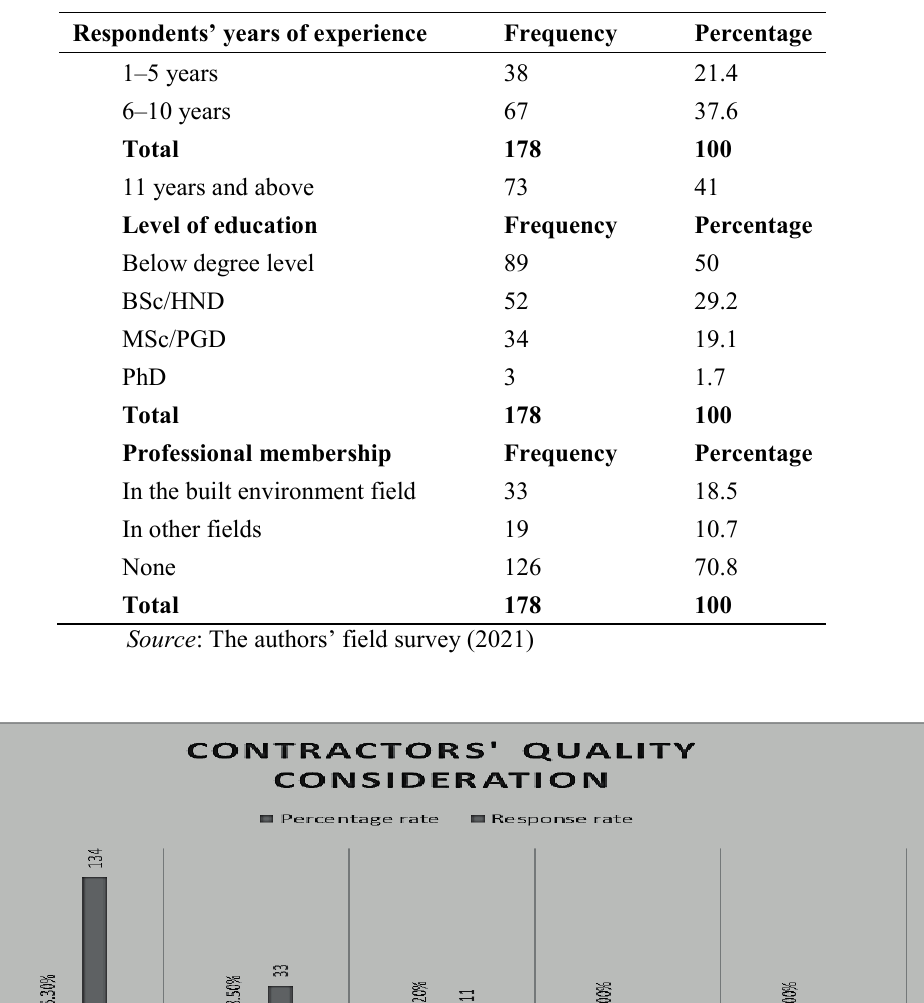
Table 2. Socio-Economic Characteristics of Respondents